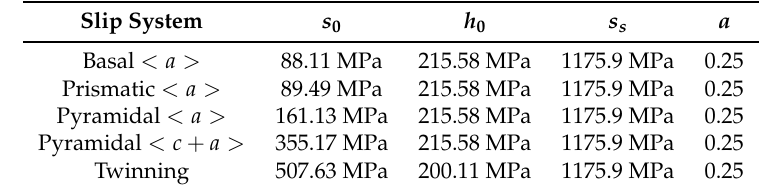
Table 1. Optimum slip system parameters of Ti-0Al.